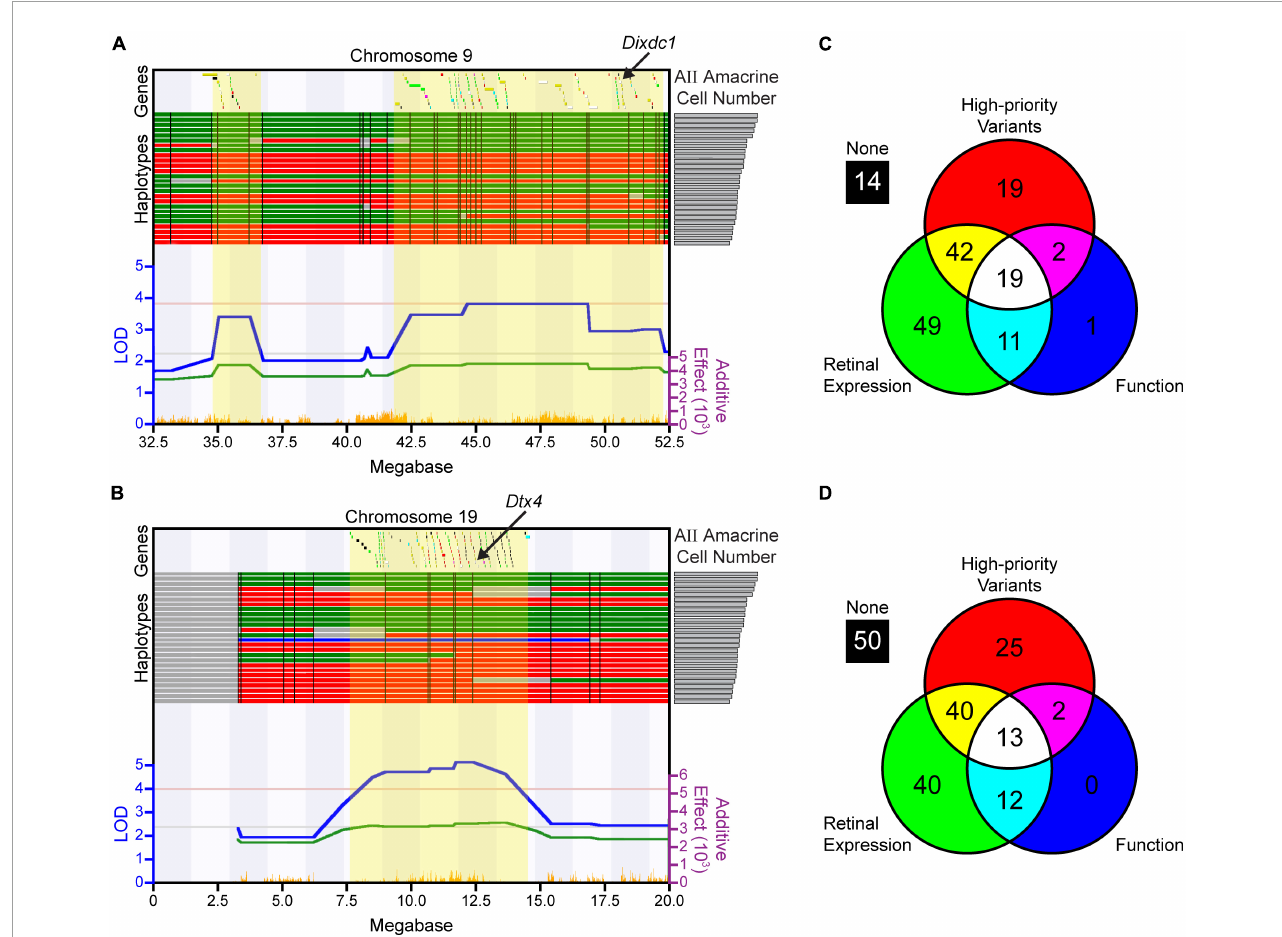
FIGURE4 Candidate gene analysis was performed at each quantitative trait locus (QTL). (A,B) All of the genes within the respective QTLs on Chr 9 (A) and Chr 19 (B) , indicated across the top of each map (positions relative to the mm9 assembly), were first interrogated for the presence of sequence variants; those containing no sequence variants were eliminated from further consideration. The remaining genes were assessed for the presence of high-priority variants, retinal expression, and relevant functions as described in the Methods. Genes are color-coded based on whether one, two, or all three of these criteria were met, based on the colors indicated in the Venn diagrams in (C,D) . The haplotype map for each strain is shown directly above the QTL map, ranked from the strain with the most AII amacrine cells (top) to the least (bottom), as indicated by the histogram from Figure 1D now shown on the right. Single nucleotide polymorphisms (SNP) density across each region is shown at the bottom in orange. Other conventions as in Figure 2 . (C,D) The results of the bioinformatic analyses at each QTL are represented by Venn diagrams, revealing that 19 genes at the locus on Chr 9 and 13 genes at the locus on Chr 19 met all three criteria and were assessed further, after which, Dixdc1 and Dtx4 were chosen as the top candidate genes. Supplementary Tables 1 , 2 list all genes at each QTL, and contain a summary of the bioinformatic analysis for each, while Supplementary Table 3 describes these 32 candidate genes in greater